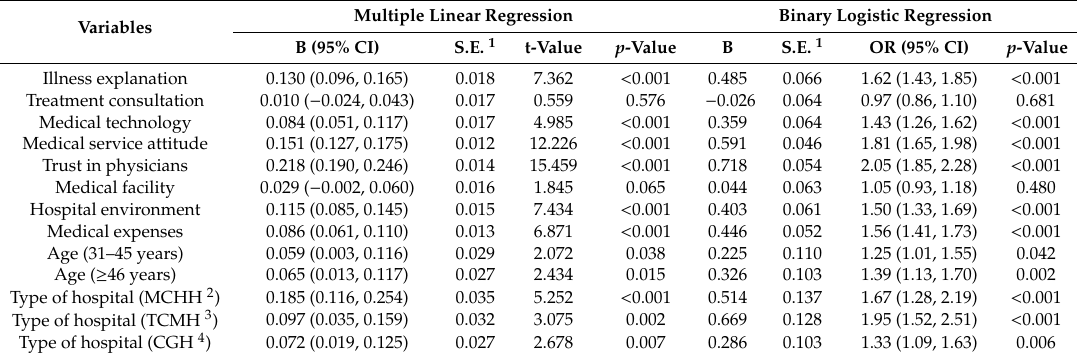
Table 5. Multiple linear regression and binary logistic regression analyses on determinants of the inpatients’ overall satisfaction with rural medical services.